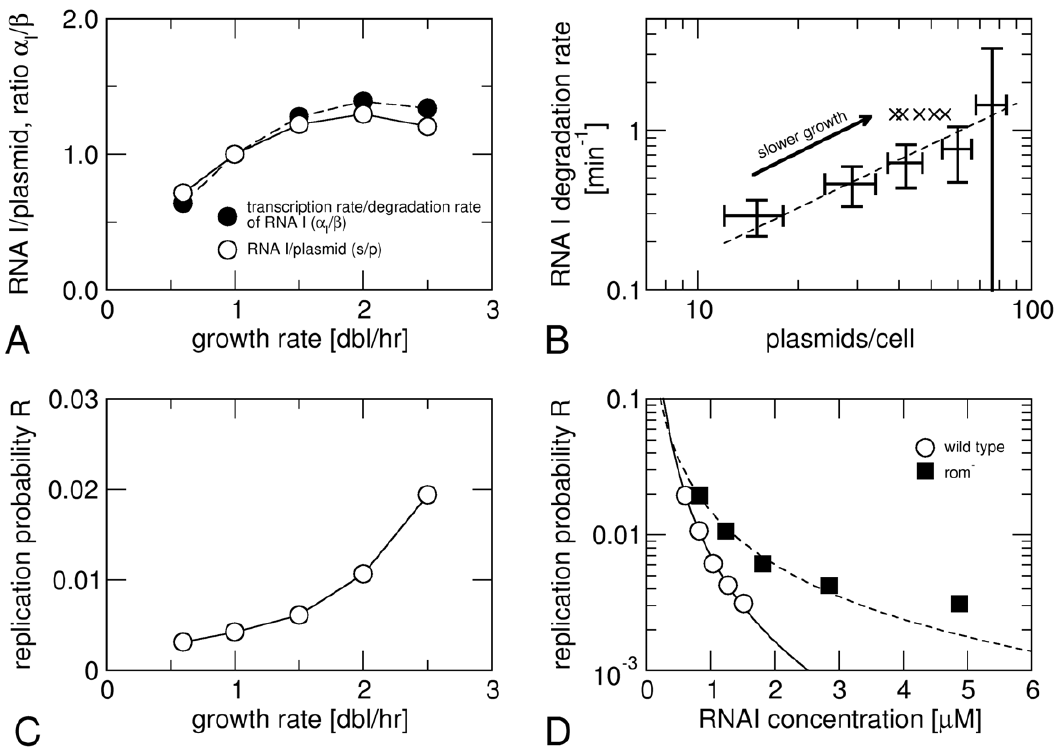
Figure 3. Analysis of plasmid copy number control using growth-rate dependent parameters. (A) Growth-rate dependence of the number of RNA I molecules per plasmid (open circles) and the ratio of the transcription and degradation rates of RNA I (filled circles), normalized to their values at 1 doubling/hour (data from Table 1). (B) Correlation between the plasmid copy number and the RNA I degradation rate at different growth rates for data from ref. [26], values calculated from (A) are indicated by crosses. (C) Growth-rate dependence of the replication probability R as calculated from Eq. (1) using data from Table 1. (D) Replication probability [as in (C)] at different growth rates plotted against the corresponding RNA I concentration for wild type and rom - plasmids. The lines are fits with the multiple-steps